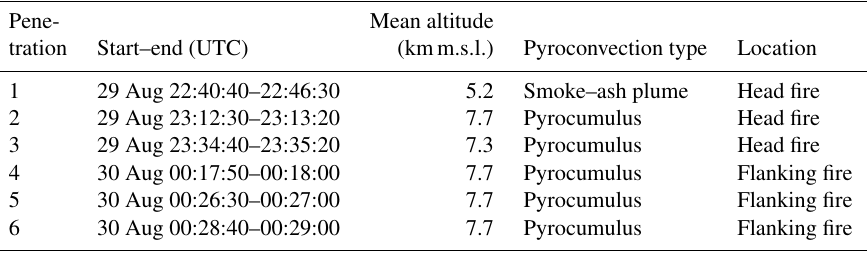
Table 2. Time periods and altitudes of the six pyroconvection penetrations examined in this study. Pyroconvection type and location of the penetrations relative to the fire are indicated (see Fig. 1d). Pene- Mean